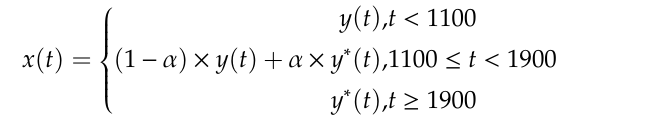
(indices 0–600), validation data in green (indices 601–800) and test (fault) data in red (indices 800–1720).